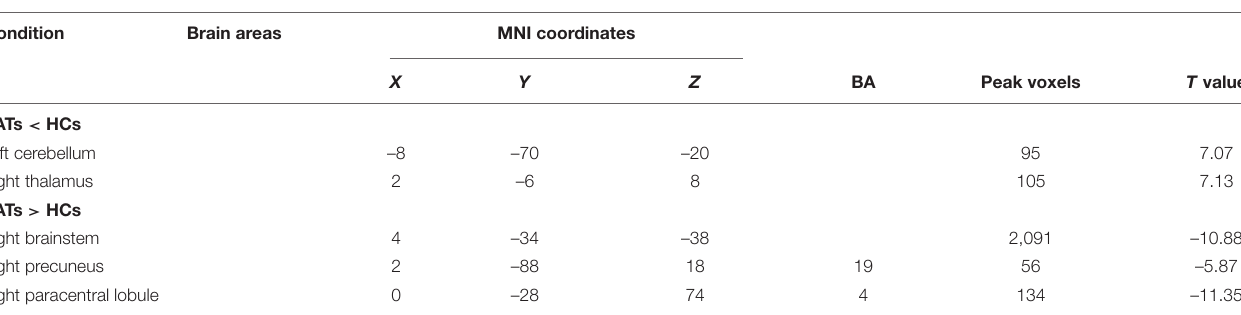
TABLE 2 | VBM brain regional differences between the PATs and the